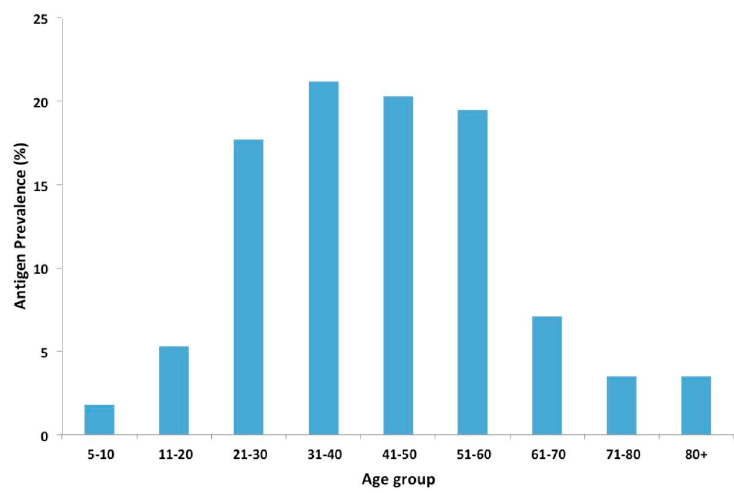
Figure 2. Prevalence of W. bancrofti antigen among participants by age groups.